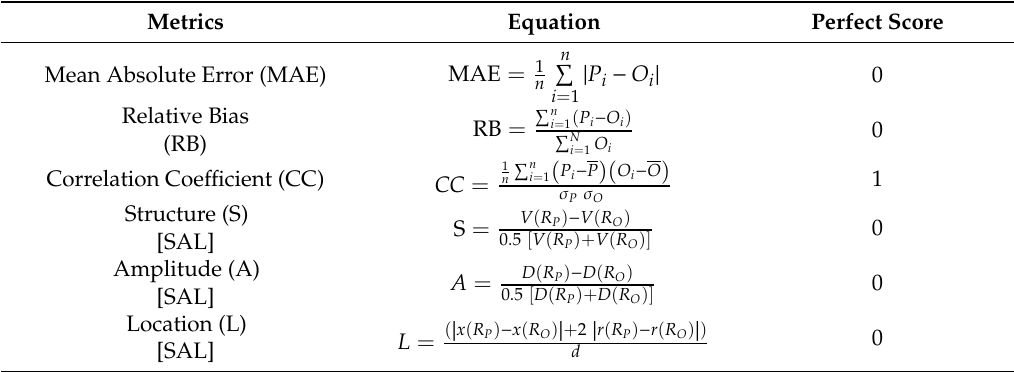
Table 4. List of metrics used to quantify the performance of rainfall products 1